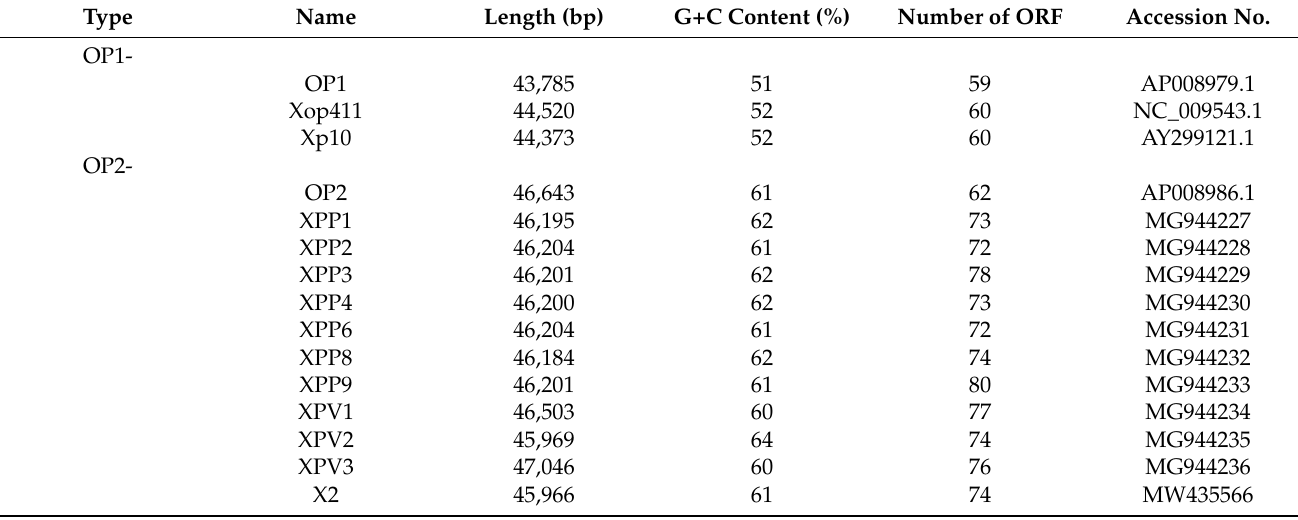
Table 3. Comparison of the available genomes of Xanthomonas oryzae pv. oryzae phages from the GenBank database.